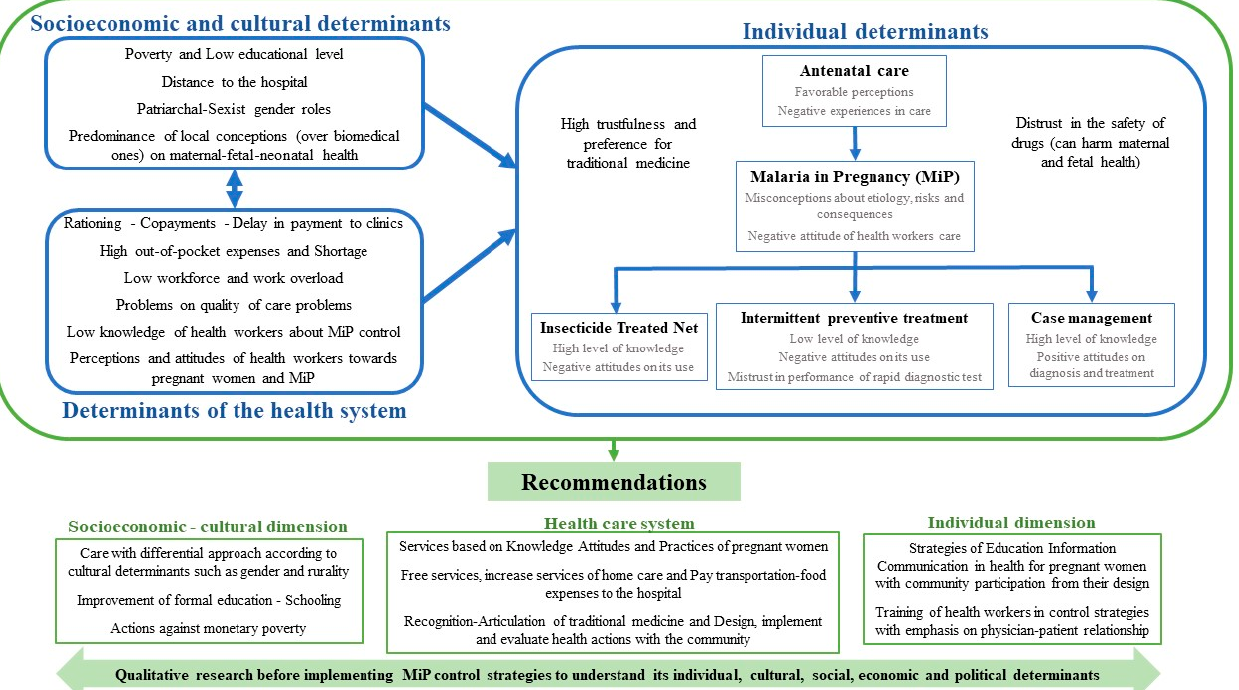
Figure 4. Meta-synthesis of socioeconomic, cultural, health system and individual determinants of MiP control.